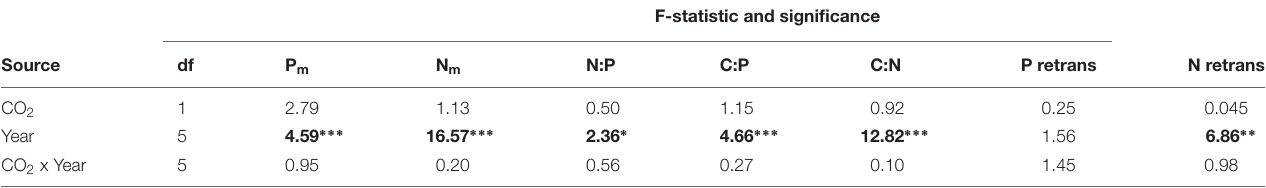
FIGURE 3 | Annual variation in chemical composition of senesced leaves collected from litter traps in February of each year (2013–2018) for (A) mass-based phosphorus in mg g − 1 , (B) mass-based nitrogen in mg g − 1 , (C) N:P ratio and (D) C:P ratio. Data are means and standard errors. TABLE 3 | Mixed model Anova table with F-statistic of senesced leaves over five years with CO 2 and Year as fixed factors and ring as random factor. F-statistic and